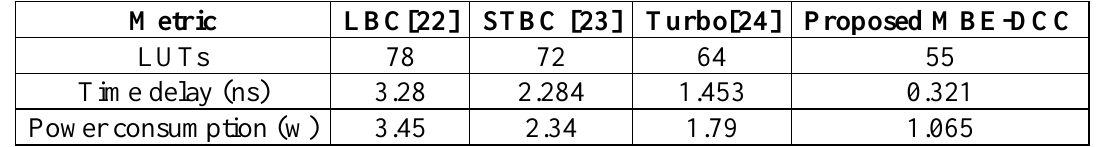
Table 4. Performance